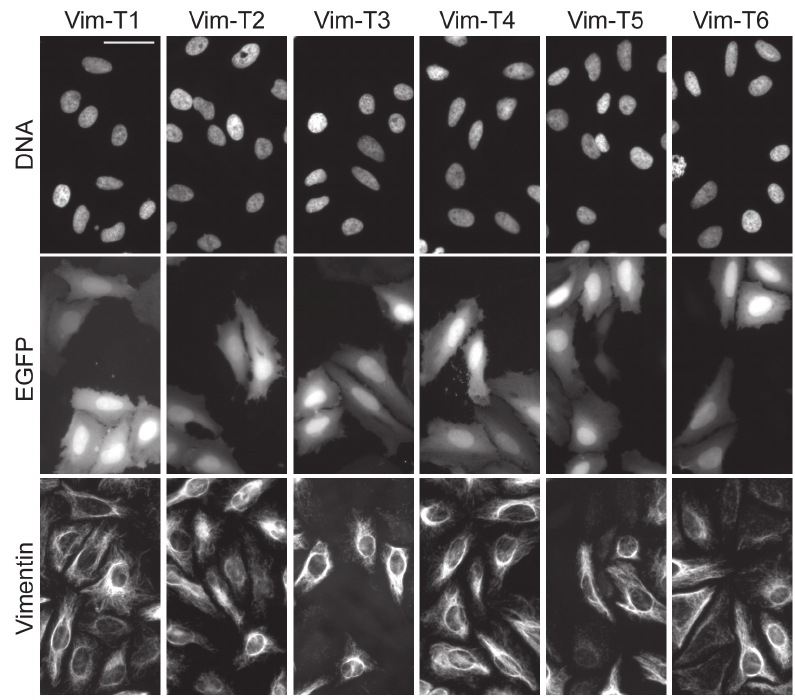
Supplemental Figure 2. RNAi of vimentin in HeLa cells with six different target sequences. HeLa cells were transfected with each of the pSHIN-G-Vim constructs. Five days after transfection, the cells were fixed and immunostained with mouse monoclonal anti-vimentin antibody. DNA, EGFP and vimentin-staining are shown for Vim-T1 to -T6 shRNA. Different levels of vimentin silencing were observed. Bar, 50 µm.